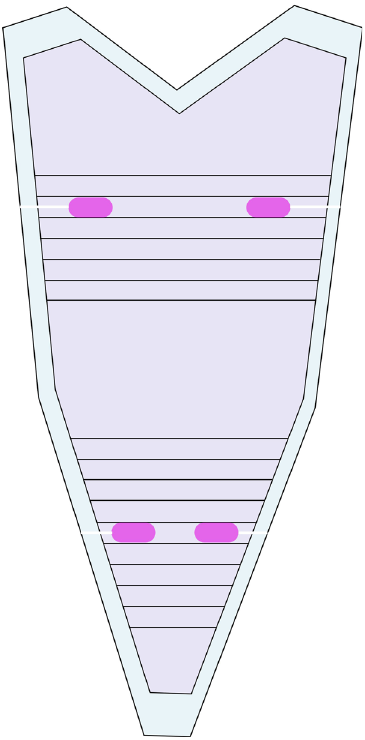
Figure 14: 3D printed anal probe with coiled silicone tube.